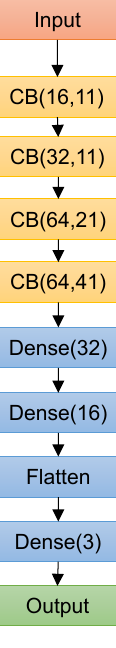
Figure 3. Deep Splicer architecture. The input layer receives the one-hot-encoded input genomic sequence, followed by four CBs, two dense layers, a flattening layer, and a final dense layer activated by the Softmax function.